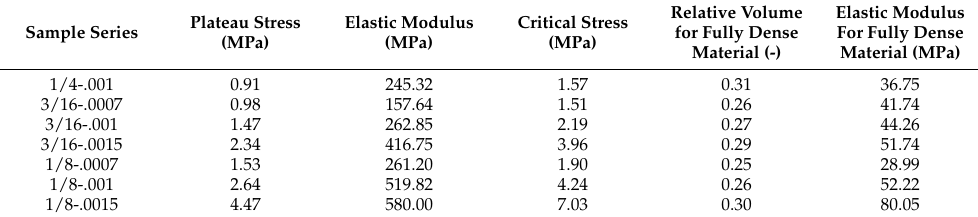
Table 3. List of basic parameters of the examined structures. Sample